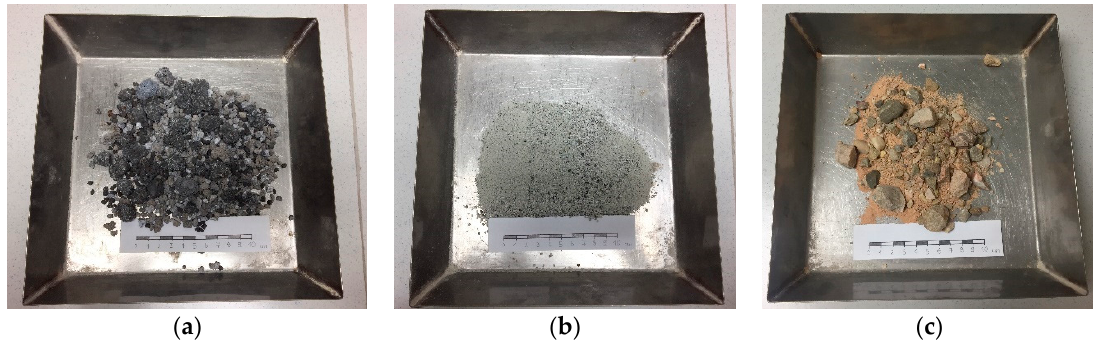
Figure 2. ( a ) EAFS; ( b ) LFS; ( c ) siliceous aggregate. Dimensions in cm. Table 2. Chemical composition of the slags under study.